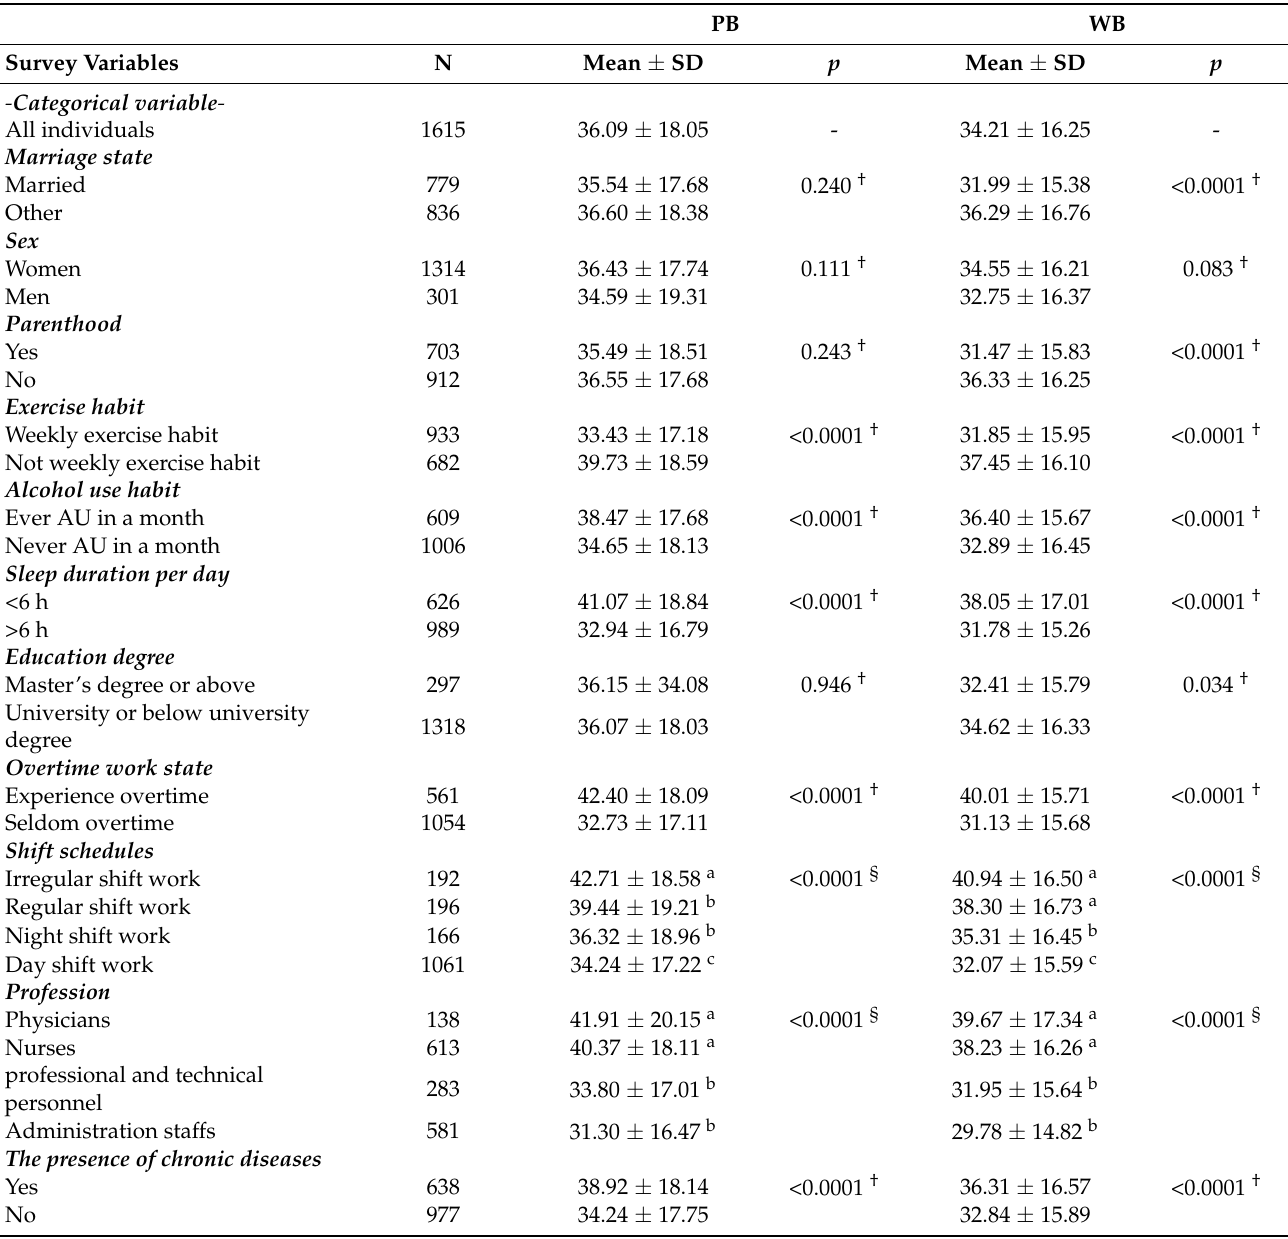
Table 1. Mean of PB and WB on Survey